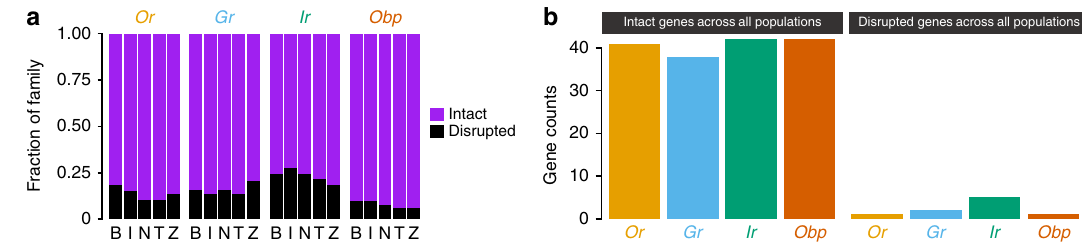
Figure 6 | Polymorphic disruptive mutations are common. Summaries for the counts and fraction of the chemosensory families that have null mutations segregating at frequencies Z 10% in the populations. ( a ) The fraction of the gene families that harbour null alleles segregating at Z 10% in the populations. B, Beijing; I, Ithaca; N, Netherlands; T, Tasmania, Z, Zimbabwe. ( b ) Counts of genes that contain either no high-frequency null mutations across the